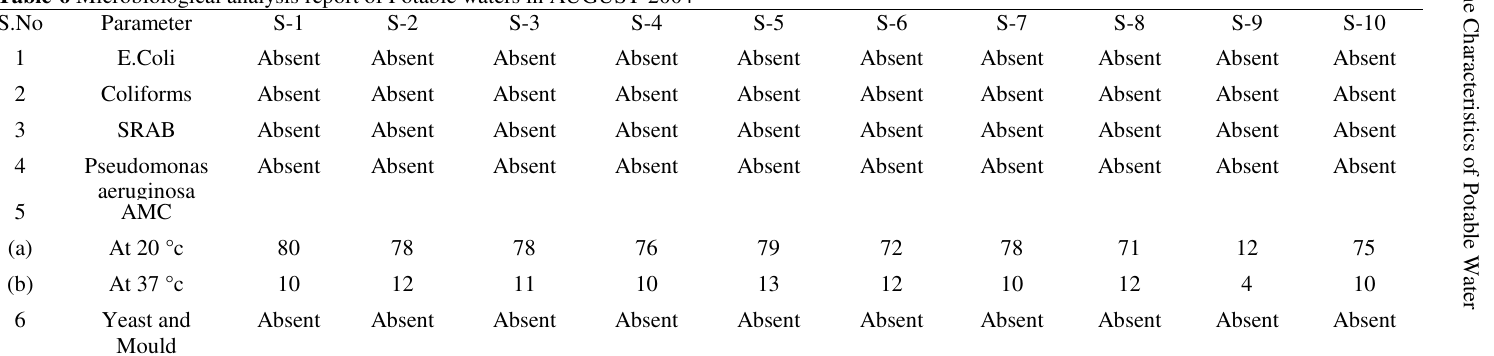
SRAB=Sulfite Reducing Anaerobic Bacteria. AMC = Aearobic Microbial